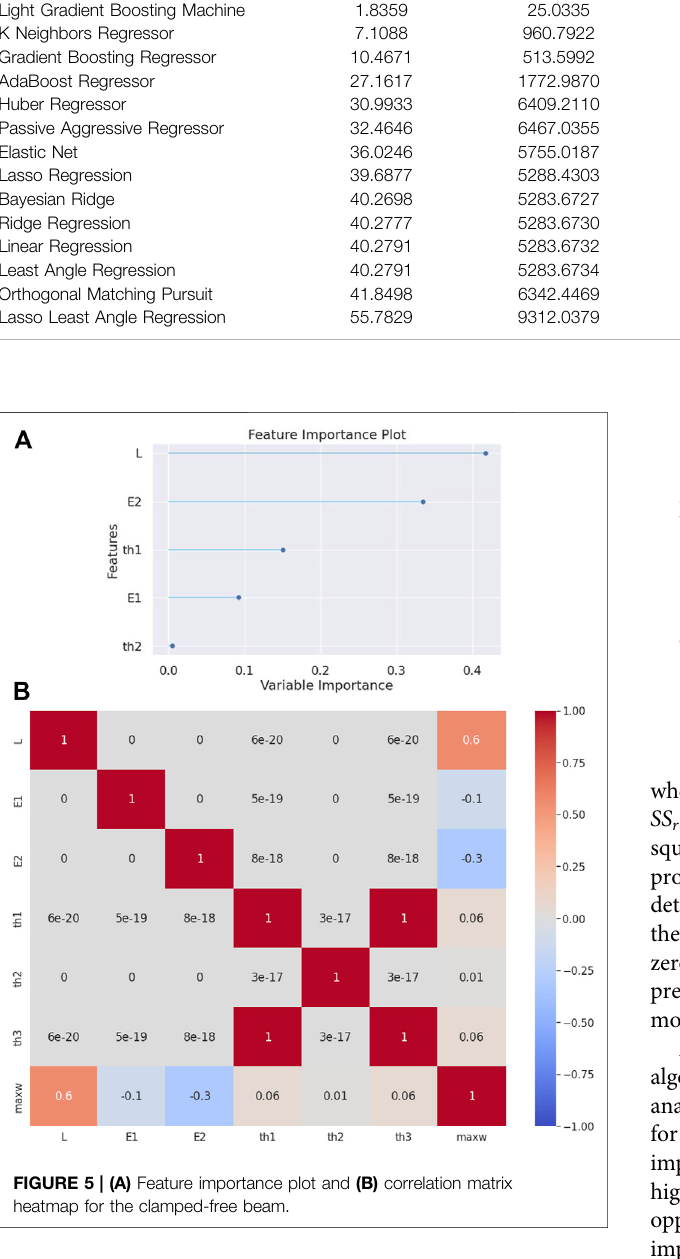
Frontiers in Built Environment |